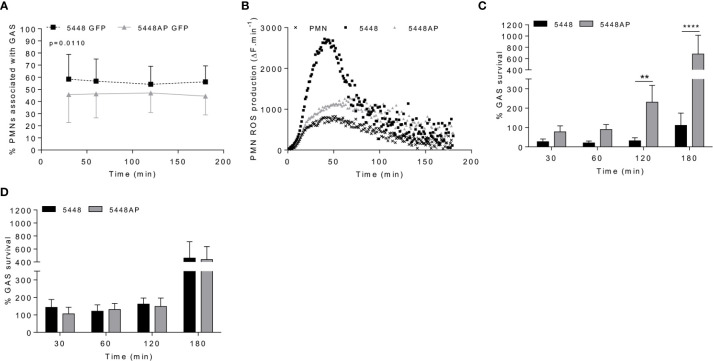
Group A Streptococcus (GAS) persistence and proliferation occurs during a dampened neutrophil reactive oxygen species (ROS) response. (A) Association of fluorescent GAS strains with human neutrophils (PMNs, n=6 donors), analysed via flow cytometry (
Figures S1A, B
). (B) Infection of human neutrophils with GAS invokes ROS production. Representative of triplicate measurements from three separate experiments (n=3 donors), shown as mean change in fluorescence units over time (ΔF.min-1). GAS strains were incubated in the presence of (C) human neutrophils (n=8 donors) or (D) lysed human neutrophils (n=4 donors) over 180 min with surviving bacterial concentration determined as percentage of inoculum. Results are the pooled means ± SD (of triplicate measurements for panels C, D). Two-way ANOVA ‘p’ values represent interaction (treatment*time) where post-hoc analysis was performed using the Holm-Šídák approach. **p < 0.01 and ****p < 0.0001.